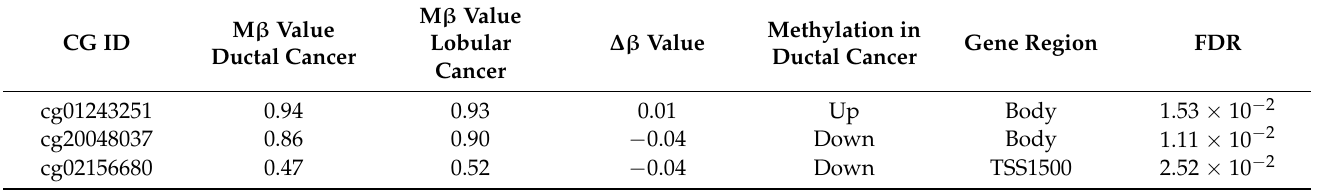
Table 4. ENPP2 DMCs identified between ductal and lobular BrCa via in silico analysis of TCGA